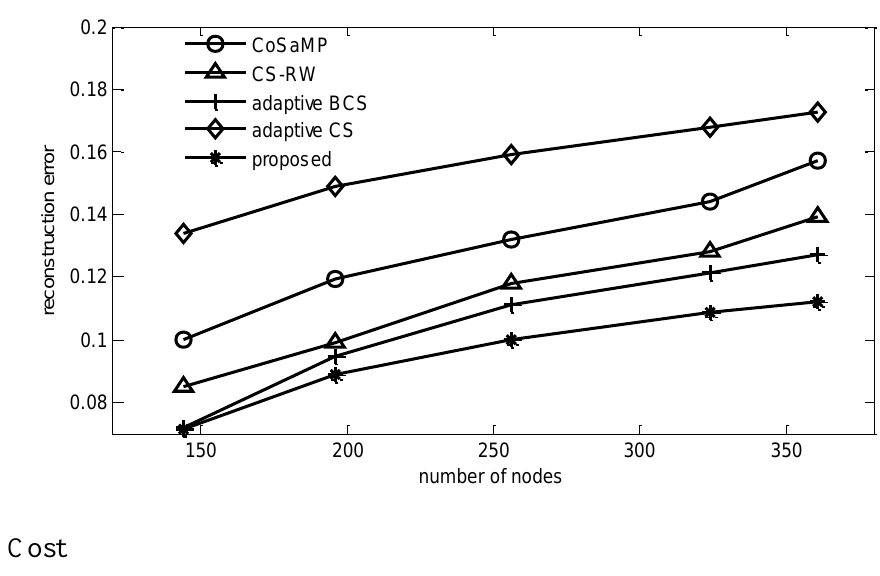
Figure 9. Reconstruction error vs. number of nodes.